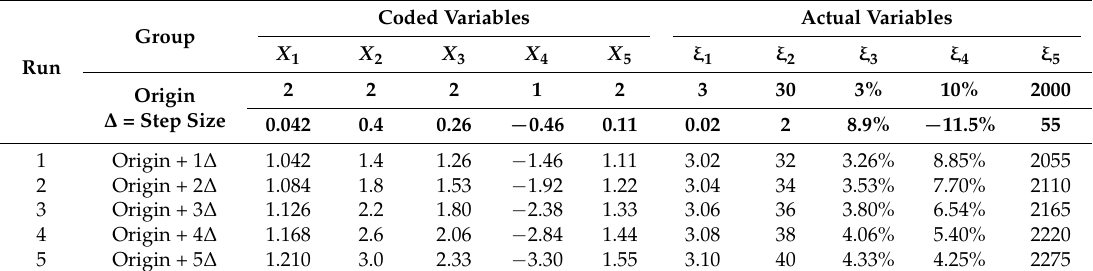
Table 2. Steepest ascent pathway design in terms of coded and actual variable.